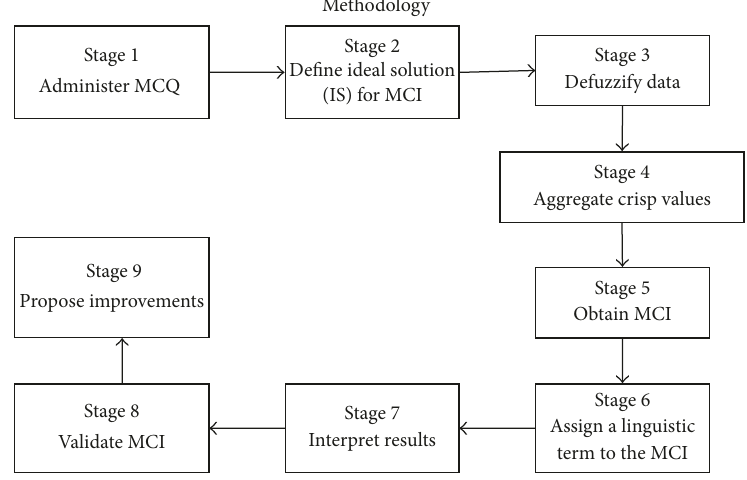
Figure 3: MCI calculation methodology.